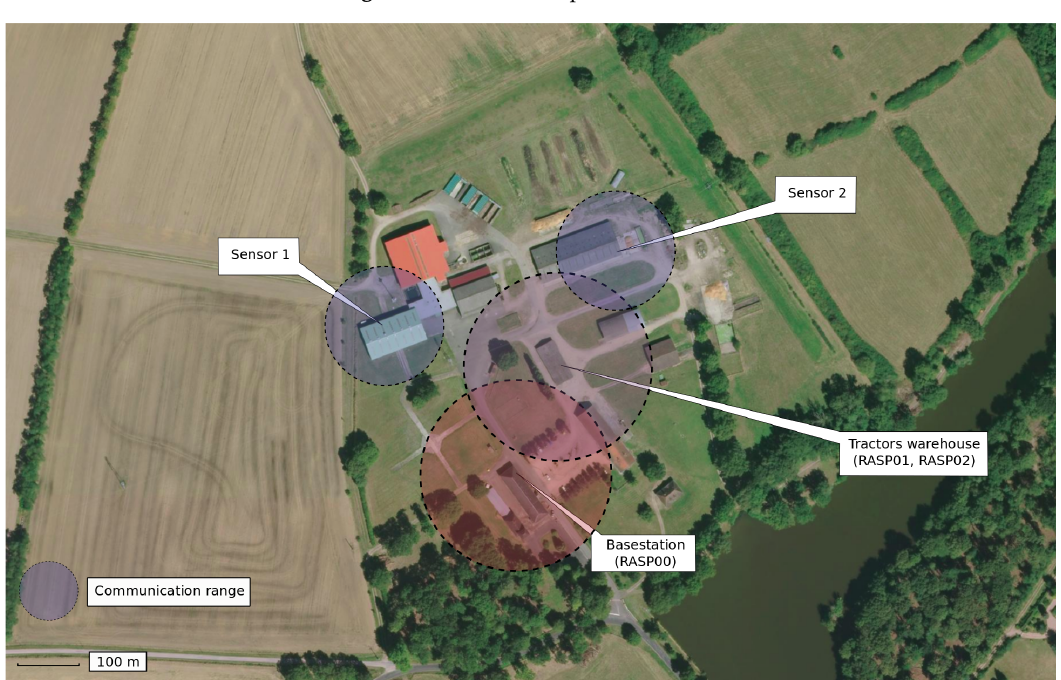
Figure 7. Node locations and their approximate communication